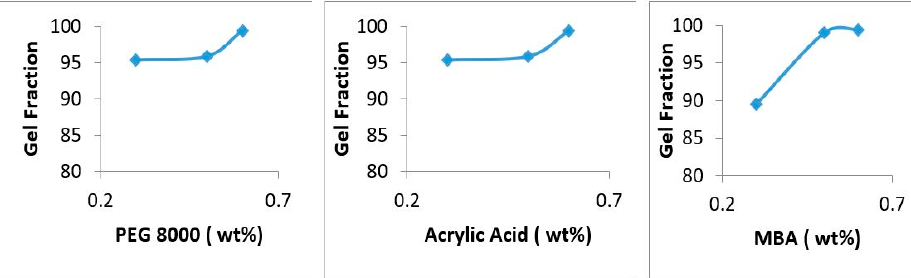
Figure 7. Gel fraction of PEG-8000, acrylic acid (AA), and